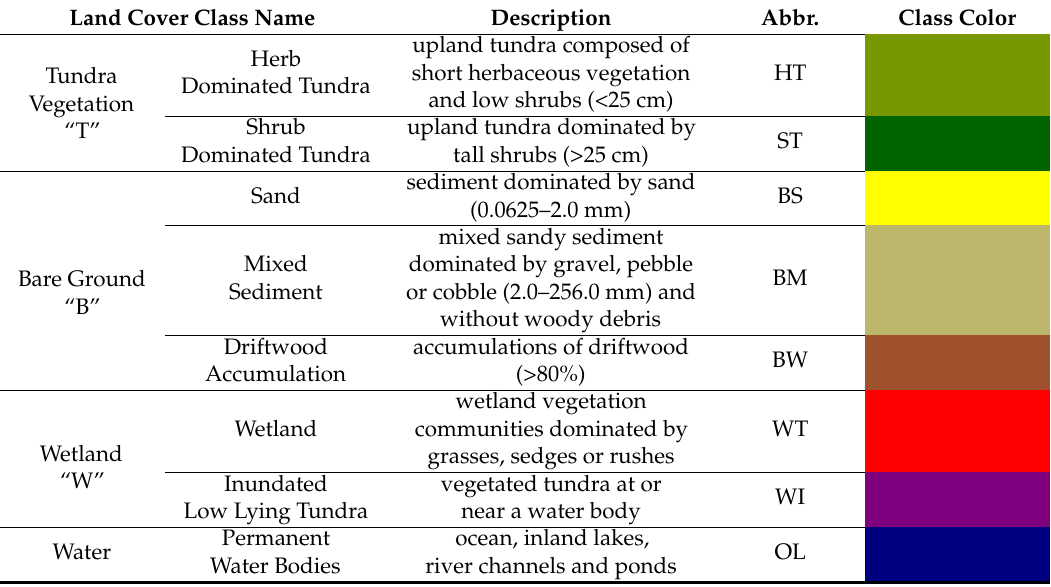
Table 2. Land cover classes considered in the analysis; description, class abbreviations (Abbr.), and class color coding. Bare Ground samples were considered homogeneous if 10% or less were “other” materials or vegetation. The letters “W”, “B”, “T” of the class abbreviations refer to Wetland , Bare Ground , and Tundra land cover